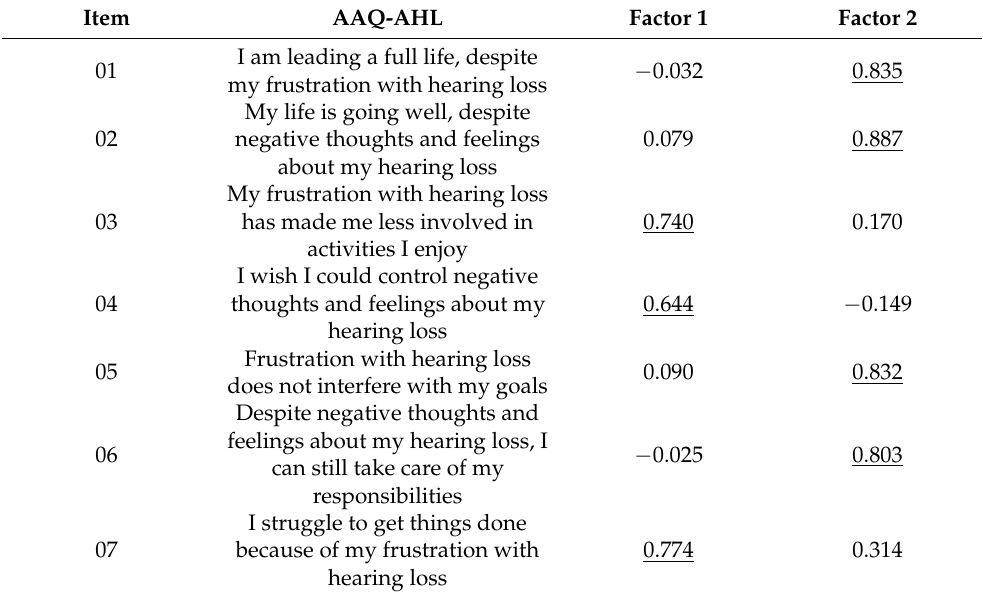
Table A2. Varimax Rotated Factor Structure of the Acceptance and Action